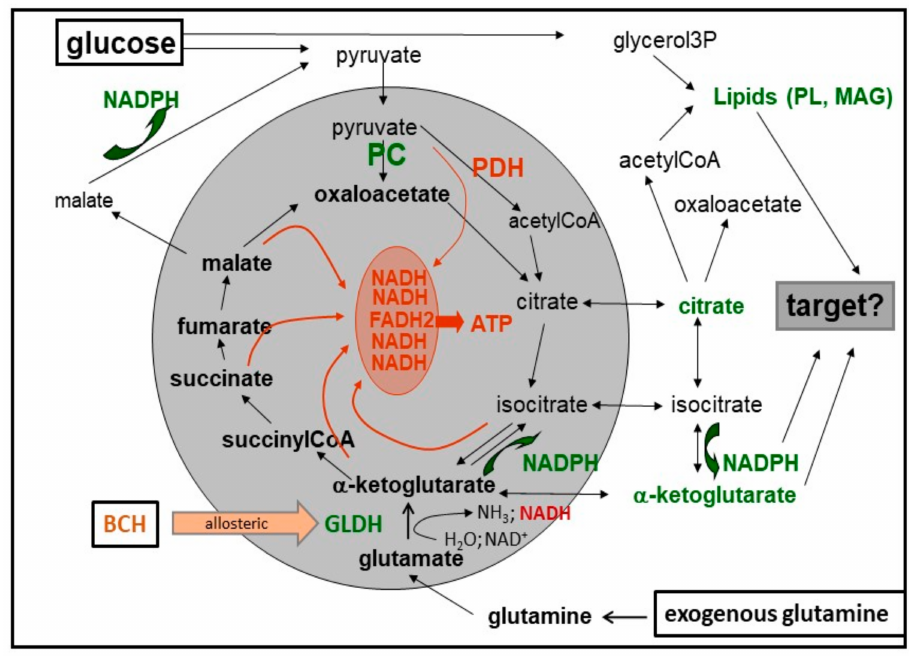
Figure 4. The provision of the citric acid cycle with alpha-ketoglutarate may not only run via transamination but also via glutamate dehydrogenase. This enzyme is allosterically activated by leucine and by ( ± ) BCH, a non-metabolizable leucine analog. In principle, the reaction can run in either direction, but normally the level of endogenous glutamate is sufficient to support the generation of alpha-ketoglutarate. The deaminating, anaplerotic reaction is further enhanced by the exogenous offer of glutamine. The cataplerotic export of acetoacetate, which depends on sufficient levels of succinate, is omitted for clarity. Abbreviations: BCH = 2-amino-bicyclo [2.2.1]heptane-2-carboxylic acid, GlDH = glutamate